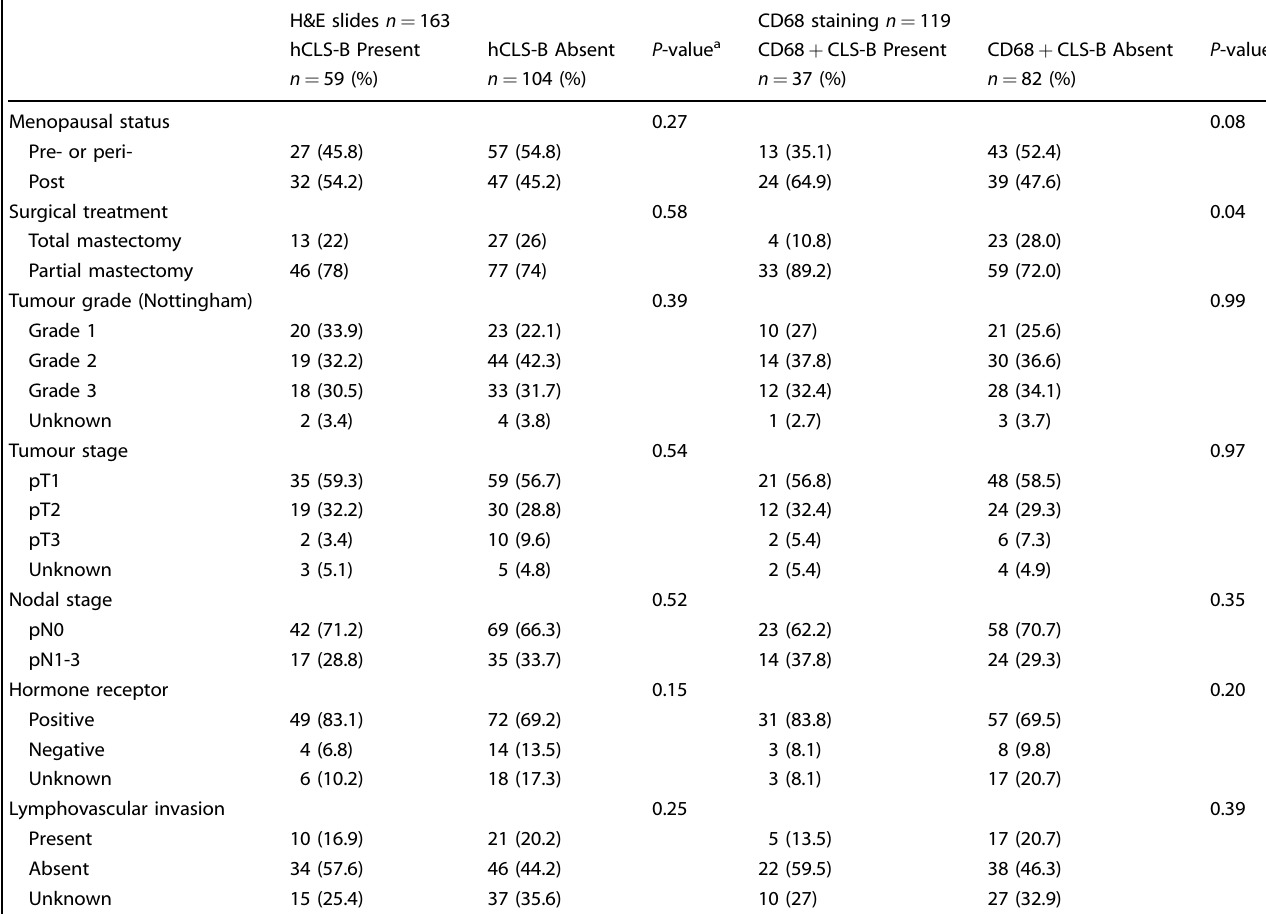
Table 2. Association of hCLS-B and CD68 + CLS-B with patient clinicopathologic